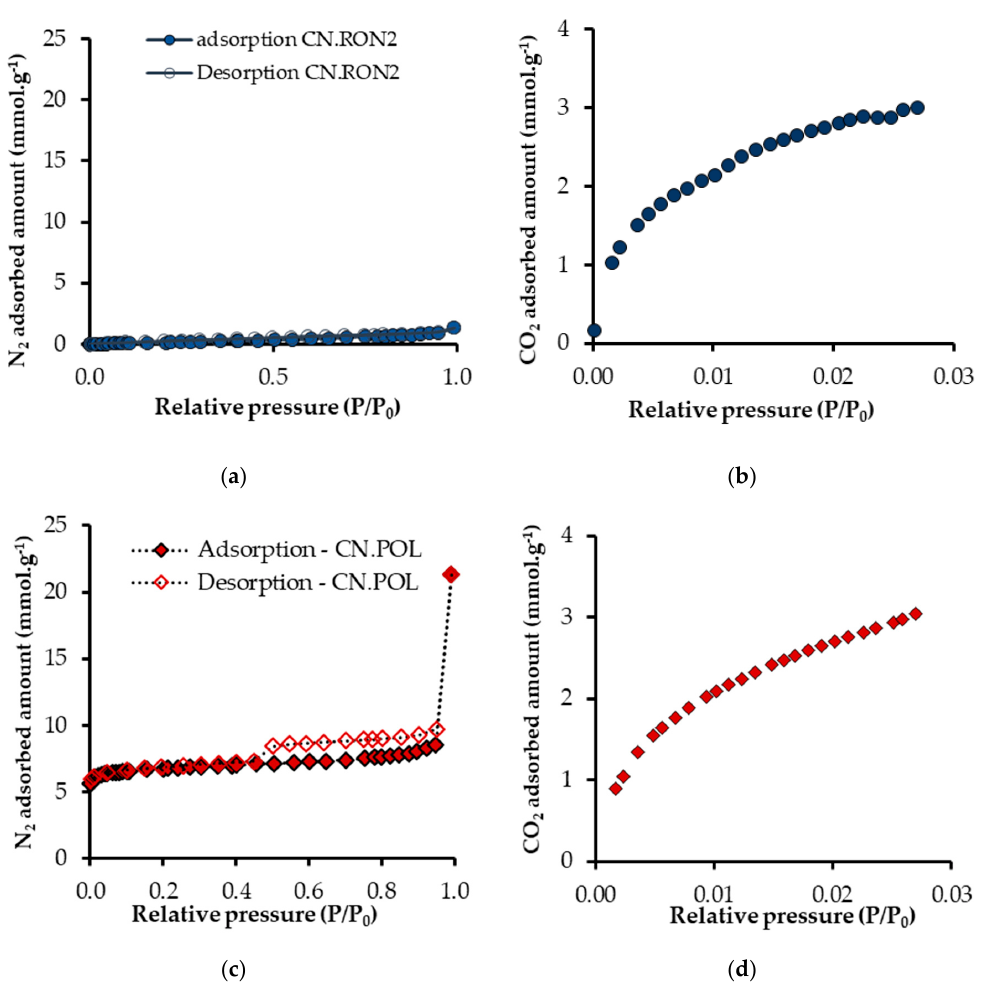
Figure 4. Adsorption isotherms of N 2 ( − 196 °C) and CO 2 (0 °C) for materials synthesized: ( a ) and ( b ) CN.RON2, and ( c ) and ( d ) CN.POL. Table 5. Parameters obtained from adsorption isotherms (N 2 at − 196 ◦ C and CO 2 at 0 ◦ C) for CN.POL Table 5. Parameters obtained from adsorption isotherms (N 2 at − 196 °C and CO 2 at 0 °C) for CN.POL and and CN.RON2.